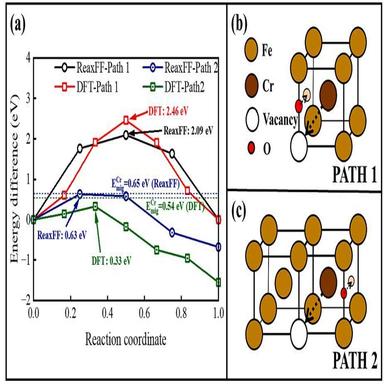
(a) The energy profile during the substitute Cr diffusion in the presence of O, and the schematic diagram of the two migration paths ((b)PATH1 and (c) PATH2) are shown. The diffusion barrier in the absence of O is also marked in the Figure, and both the results calculated by present ReaxFF and DFT are provided.